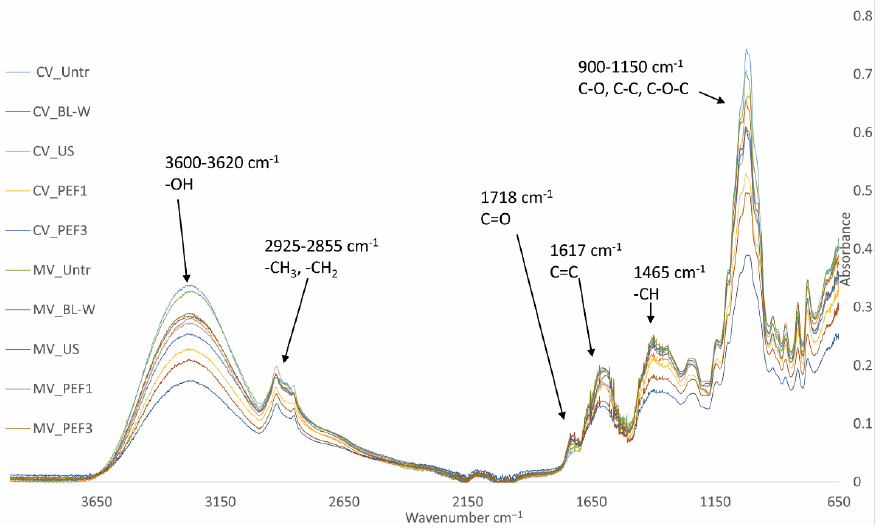
Figure 7. Fourier-transform infrared (FTIR) spectra of convective (CV) and microwave–convective (MV) dried red bell pepper subjected to thermal or non-thermal treatment prior to